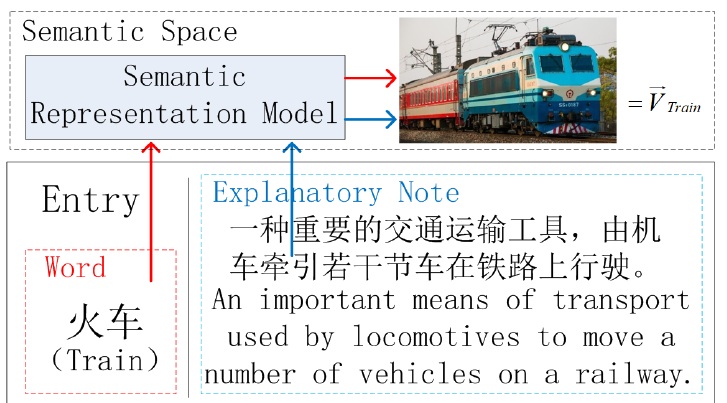
Figure 1. An entry’s construct and the semantics relationship between the word and the explanatory note. A Chinese word usually contains multiple Chinese characters. Although “train” is not a low-frequency word in Chinese, we use it as an example for